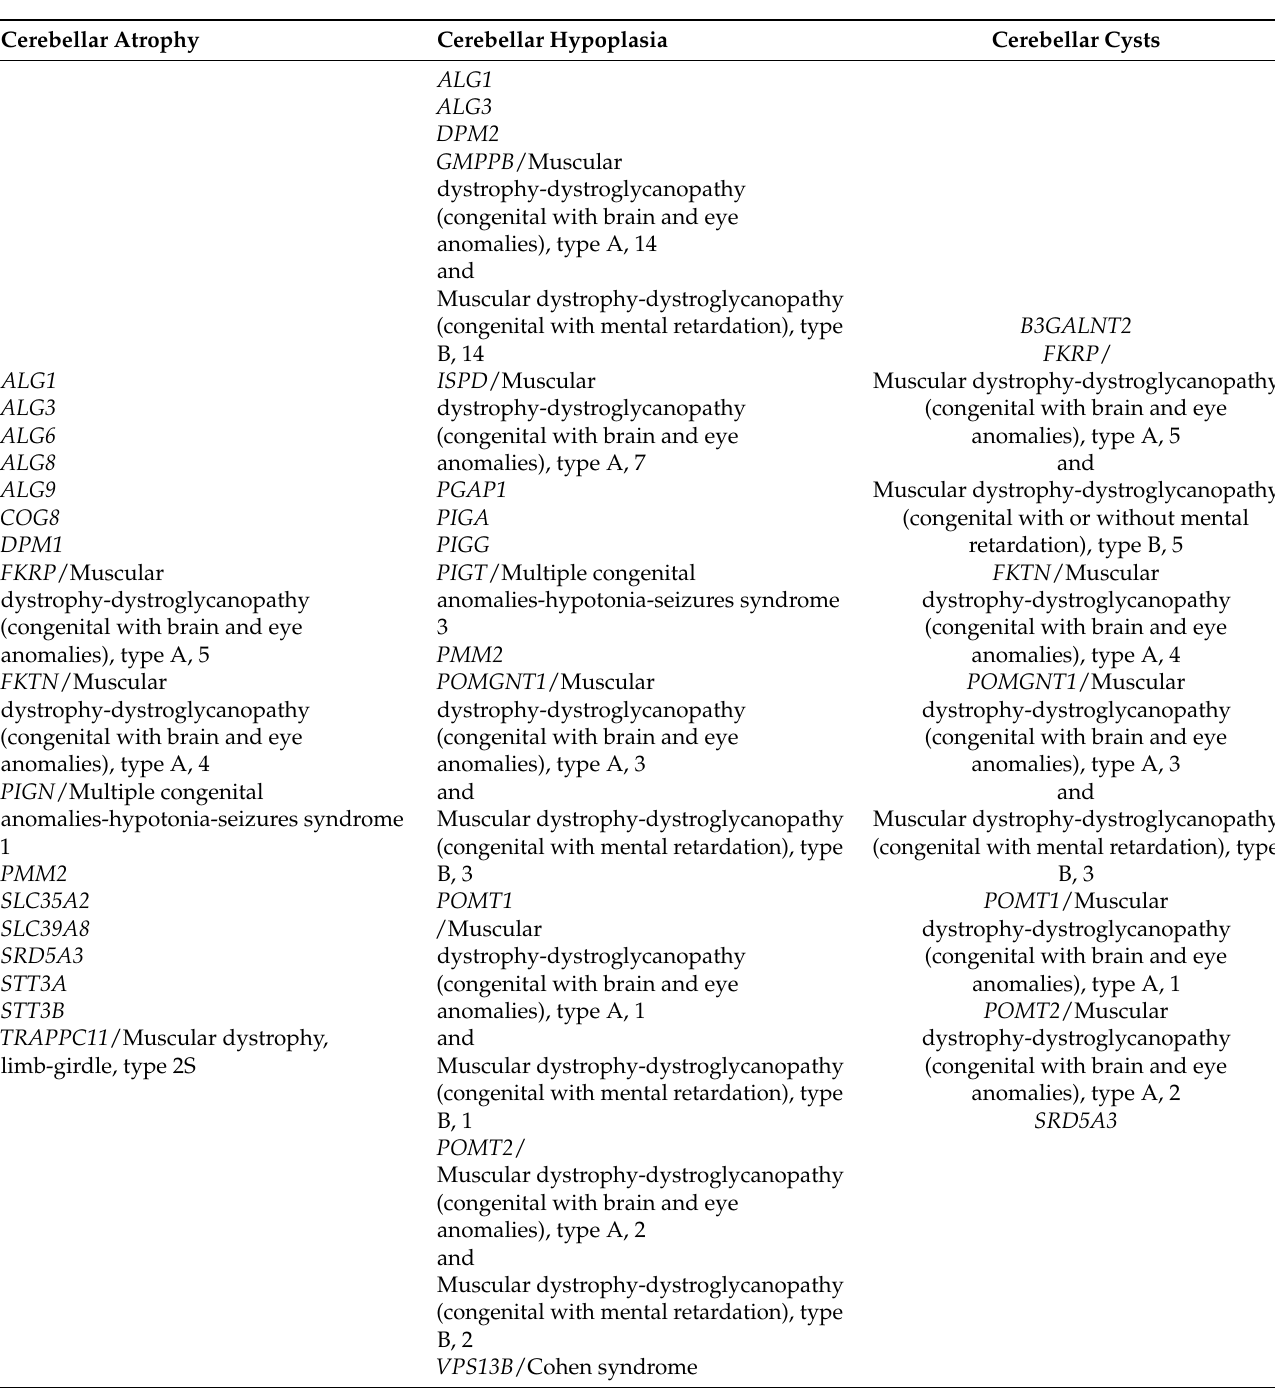
Table 3. Most frequent cerebellar anomalies and ataxia in specific CDG types (the names of the diseases are given